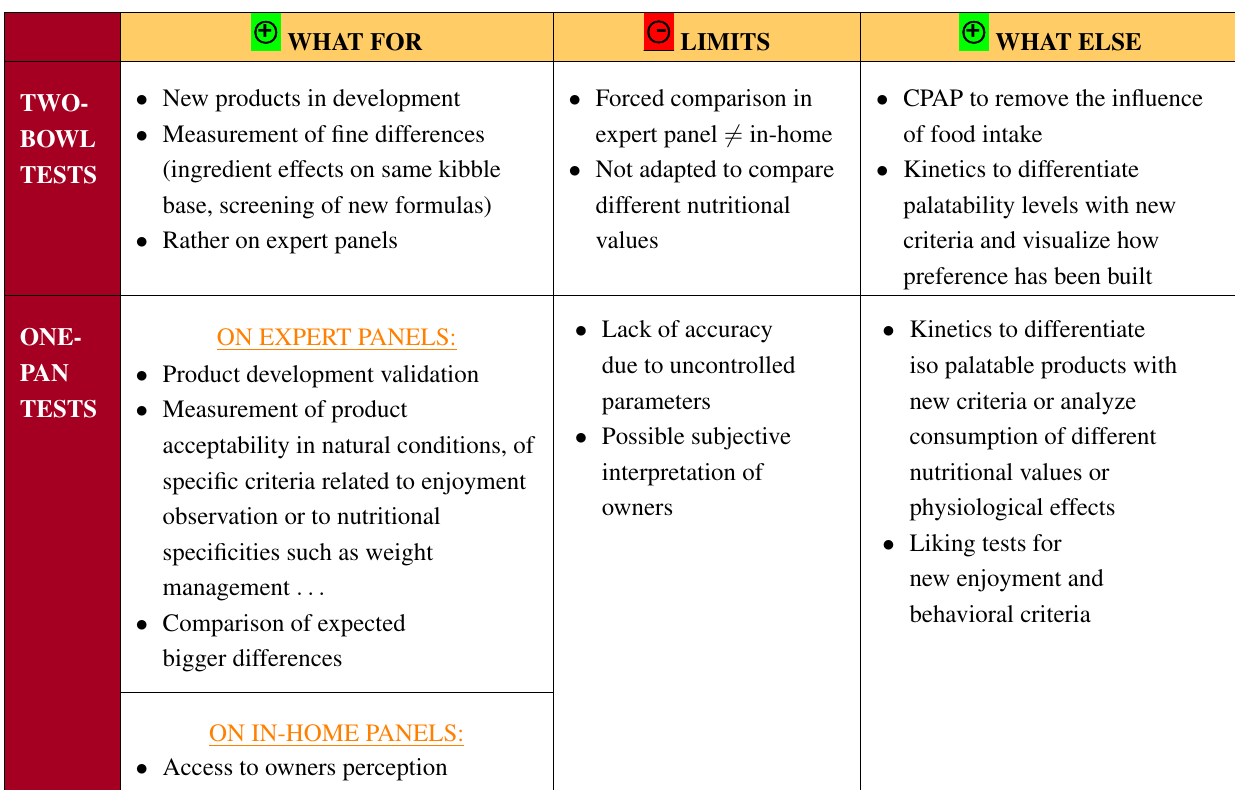
Table 1. Summary of the pros and cons of the different methods. ○ + WHAT